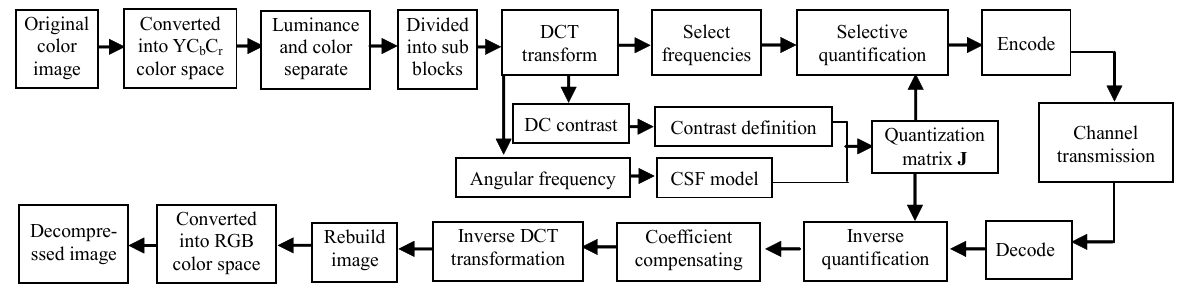
Fig. 3 Flow charts of the compression scheme combining the human visual